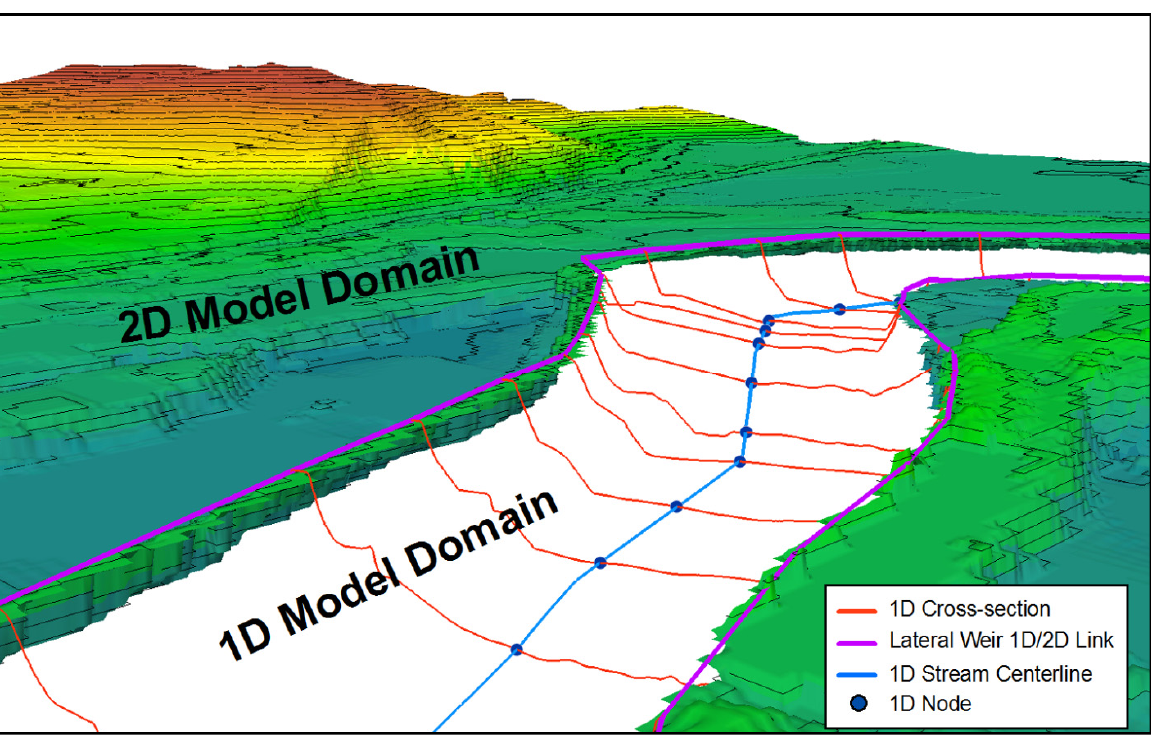
Figure 7 . Depiction of a general 1D model of the river channel coupled with a 2D model of the